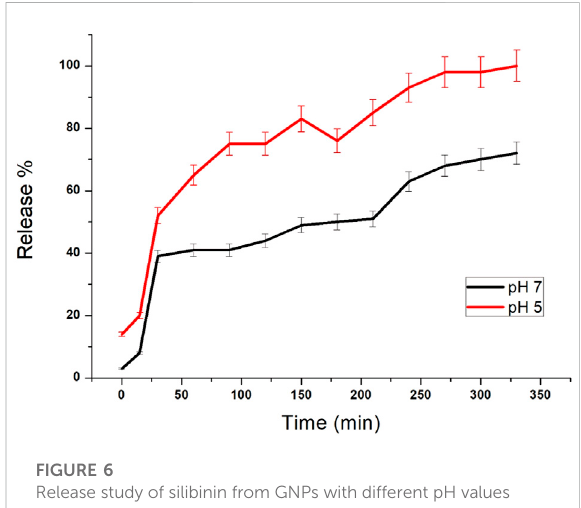
FIGURE 6 Release study of silibinin from GNPs with different pH values (pH 5 and 7). Each point represents the outcome of a pair of readings, with many points showing errors smaller than the